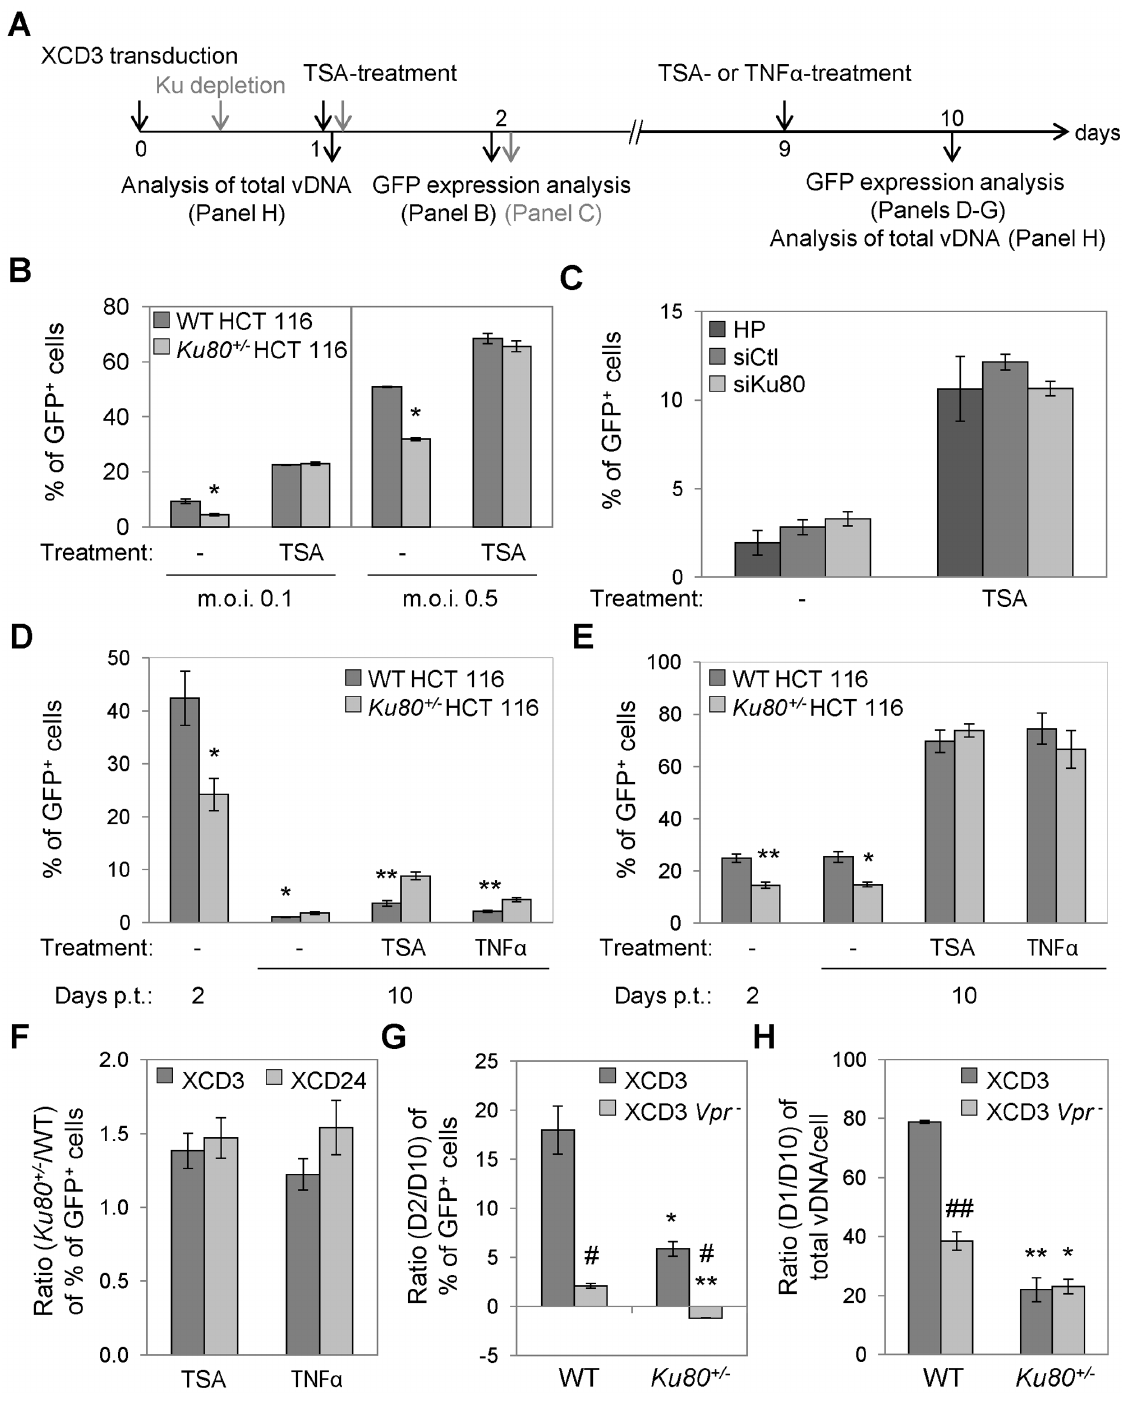
Figure 6. Ku80 haplodepletion increases the level of TNF a - or TSA-induced HIV-1 reactivation. ( A ) Schematic representation of the experimental strategy adopted in this figure. ( B–D ) Wild-type (WT) and Ku80 + / 2 human colon carcinoma HCT 116 cells transduced with XCD3 (at an m.o.i. , 0.6) ( B , D ), and WT HCT 116 cells transfected with an unrelated sequence (siCtl) or with siRNAs directed against Ku80 (siKu80) 8 h after XCD3 transduction ( C ), were incubated for 24 h in the absence or presence of trichostatin A (TSA) or tumor necrosis factor a (TNF a ) either 24 h ( B , C ), or 9 days upon transduction ( B , D ). The percentage of green fluorescent protein-positive (GFP + ) cells was then estimated by flow cytometry. In panel ( C ), HP (Hiperfect H ) corresponds to cells transfected only with the same amount of liposomes used for siRNA transfection. In panel ( B ), the results of two independent experimentations performed in duplicate are reported (mean 6 SD, n =4). *, p , 0.05, as compared to WT cells. Panels ( C , D ) show results from 2 and 4 independent experiments, respectively (mean 6 SEM). *, p , 0.05; **, p , 0.01, as compared to WT cells. ( E ) WT and Ku80 + / 2 HCT 116 cells transduced with XCD24 were treated 9 days later with TSA or TNF a as described in ( D ) (mean 6 SEM, n =3). *, p , 0.05; **, p , 0.01, as compared to WT cells. ( F ) Ratio between the percentage of GFP + cells of Ku80 + / 2 and WT cells in the presence or absence of TSA or TNF a , as determined in ( D ) and ( E ) for the depicted lentiviral (LV) vectors (mean 6 SD, n =3). ( G ) Ratio between the percentage of GFP + cells observed upon 2